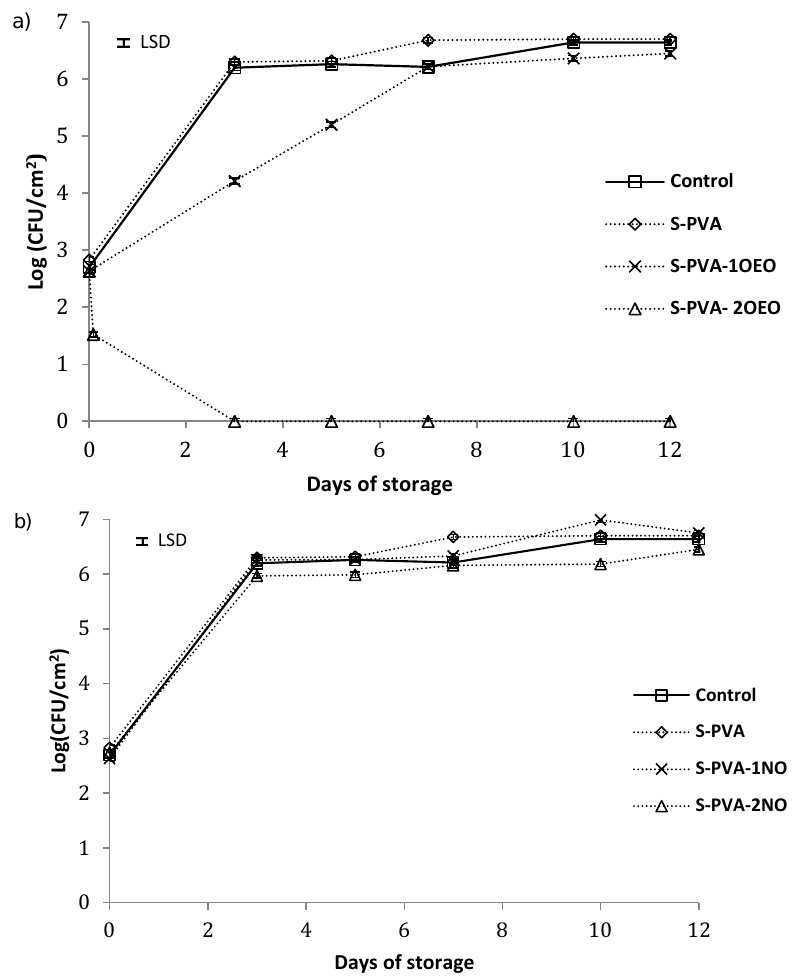
Figure 5. Population viability of Penicillium expansum on PDA medium incubated at 25 °C. ( a ) Films with and without oregano essential oil (OEO) and ( b ) films with and without neem oil (NO). Mean values for each incubation period and 95% LSD interval are included in the plot. (LSD = ±0.05).